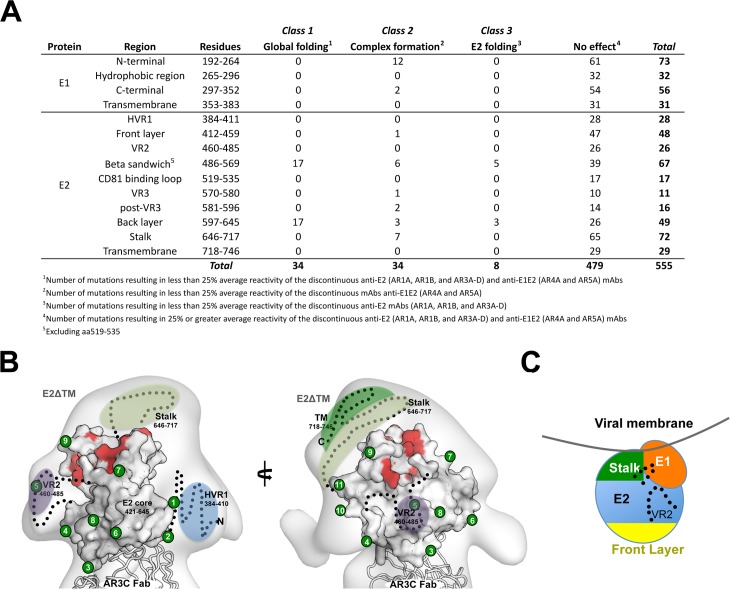
The stalk, VR2, and a glycan-free face of E2 may play a role in the E1E2 interface.(A) Classification of E1E2 residues based on the effects of mutations on antibody binding. (B) The location of Class 2 residues (mutation affected E1E2 complex formation) are indicated in red on the structure of E2 with the transmembrane region removed (E2ΔTM) [15]. Regions that are missing or disordered in the structure are represented by black dotted lines. The area containing HVR1 is highlighted in blue, VR2 is in purple, and the stalk and transmembrane regions are in light and dark green, respectively. The locations of glycans are indicated by green circles and are numbered beginning with the N-terminus. (C) A general model of the E1E2 interaction indicates that the stalk region, the base of VR2, and a portion of E2 opposite of the front layer and CD81bs (i.e. VR3, post-VR3 and back layer) possibly interacts with E1. Dots indicate region of E2 that may interact with E1.